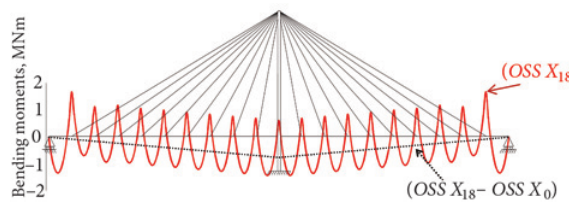
fig. 6. Bending moments in the OSS in X 18 (continuous line) and differences with X 0 (dotted line)